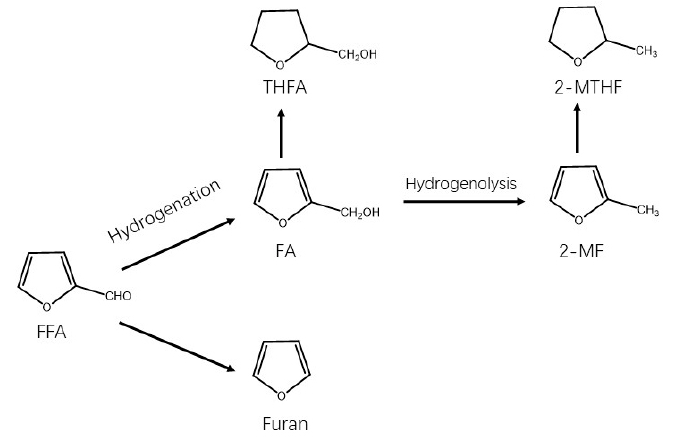
Scheme 1. The reaction mechanism for the synthesis of 2-MF.